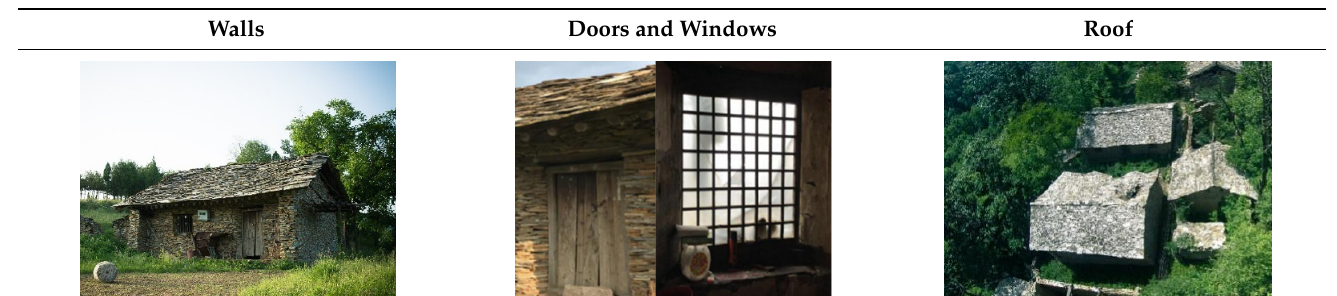
Table 1. The characteristics of slate dwellings.